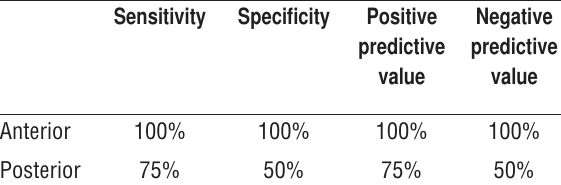
Table 1 – Results of Sono-urethrogram.